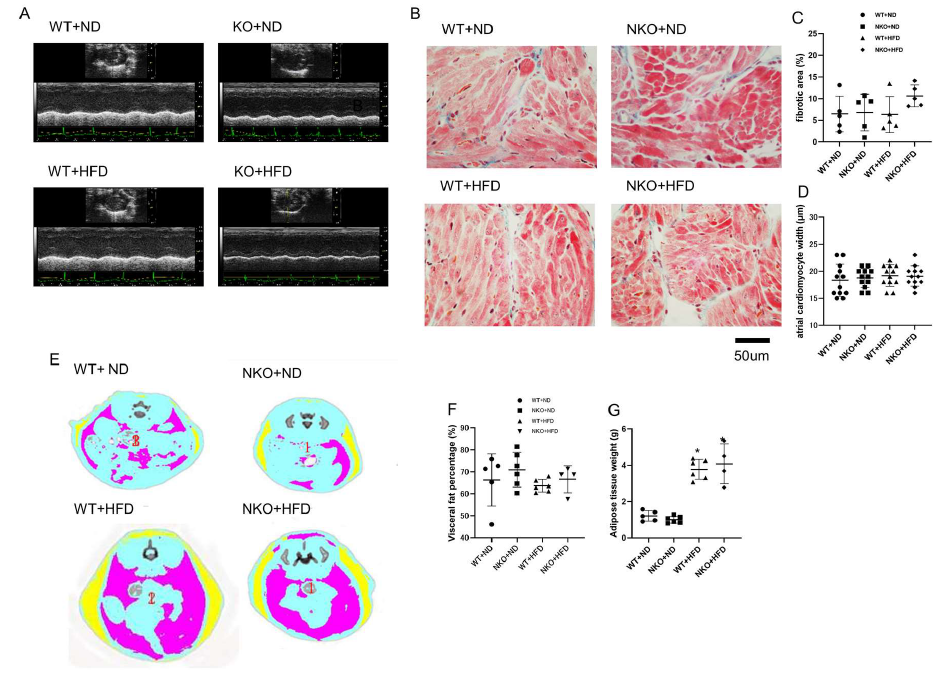
Figure 2. Echocardiography, histology, and adipose tissue measurements. ( A ) Representative M-mode echocardiographic images of a mouse heart. ( B ) Representative images of Masson trichrome staining of the atrial tissues. ( C ) Ratios of fibrotic area to total area ( n = 5 mice per group). ( D ) calculated atrial cardiomyocytes width ( n = 12 cells in 3 mice per each group). ( E ) Representative images of abdominal CT scans. Yellow: subcutaneous adipose tissue; pink: intestinal (visceral) adipose tissue. ( F ) Visceral adipose tissue weights measured by abdominal CT scans. ( G ) Subcutaneous adipose tissue weight measured by abdominal CT scan ( n = 5 mice in WT+ND group, n = 6 in NKO+ND group, n = 6 in WT+HFD group, n = 4 in NKO+HFD group). * p < 0.05 vs. WT+ND mice. Statistical comparisons